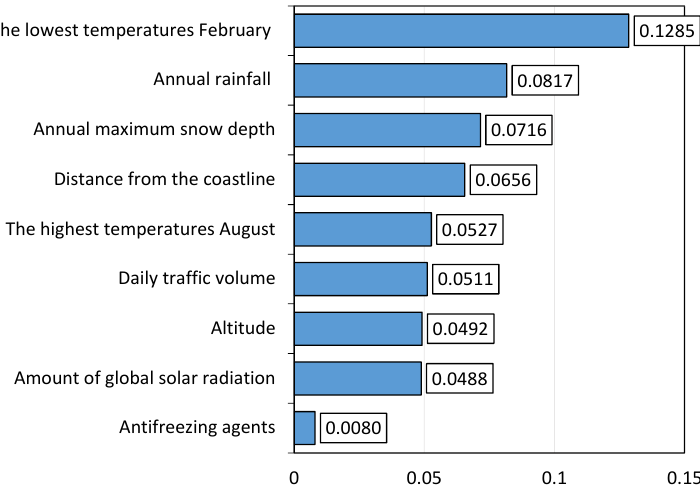
Figure 18. Range in concrete beams that have been in service for over 50 years.